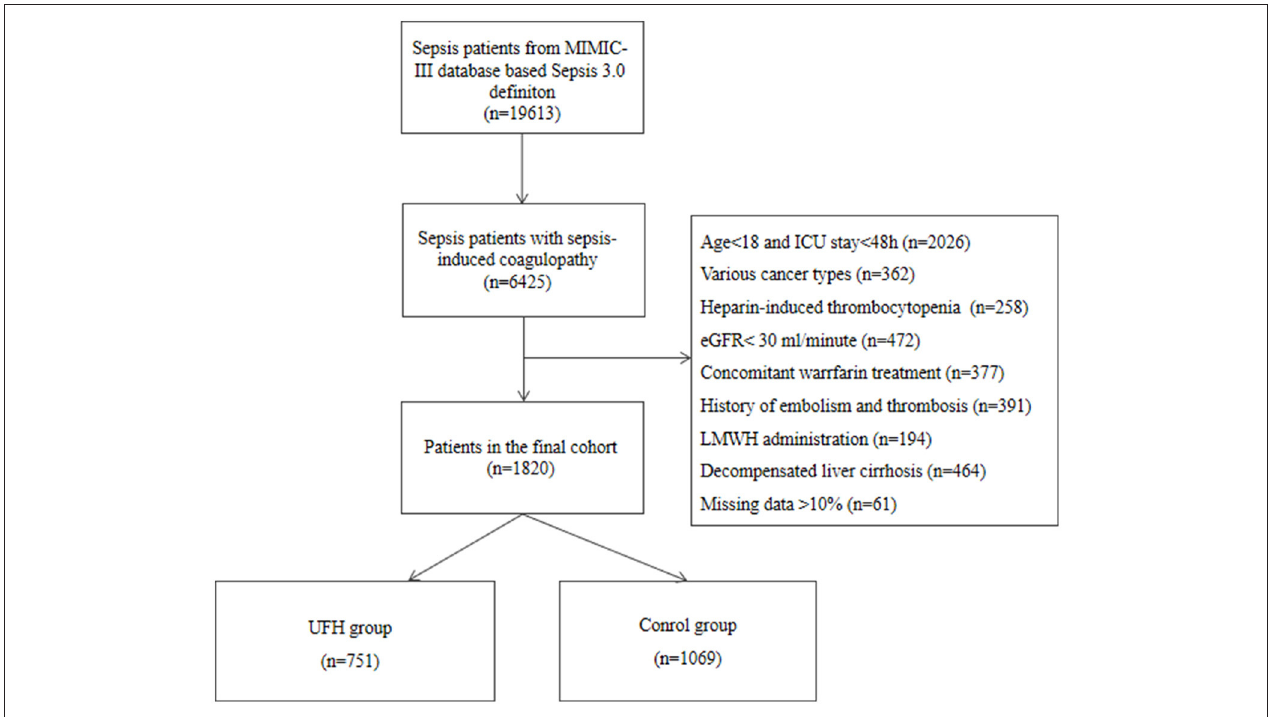
FIGURE 1 | Flow chart of the population included in the study.